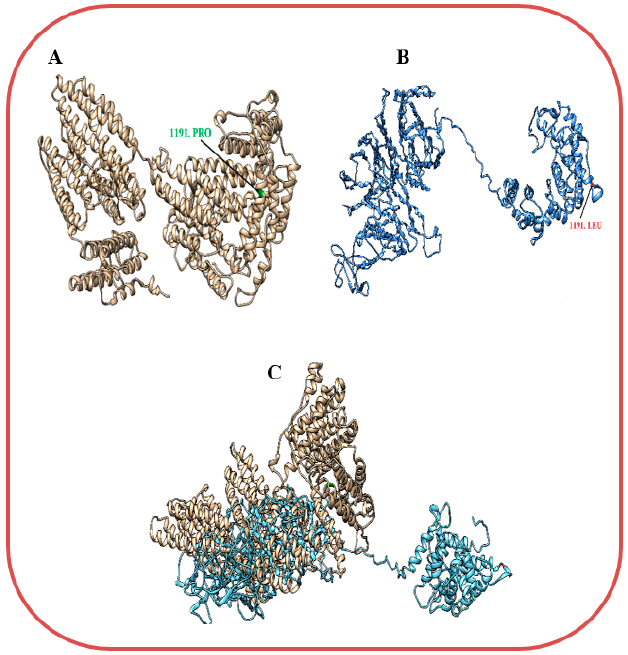
Figure 5. Three-dimensional structural presentations of KIAA0825 predicted by I-Tasser ( A ) Wildtype KIAA0825 ( B ) Mutant KIAA0825 ( C ) Superimposed Wildtype and mutant KIAA0825.